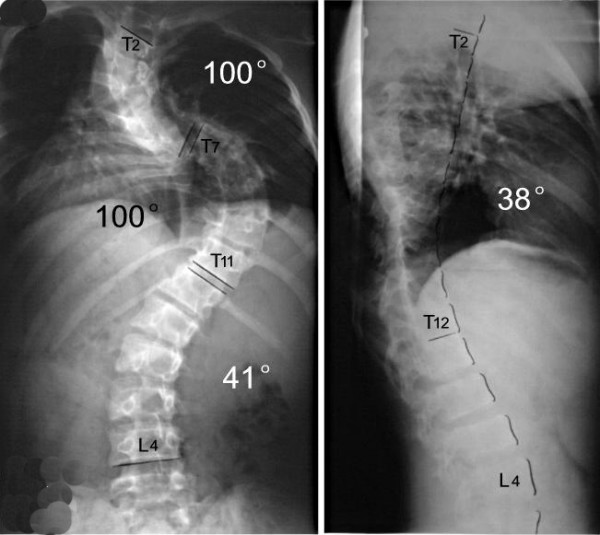
M,12Y, neurofibromatosis scoliosis, double thoracic curve.